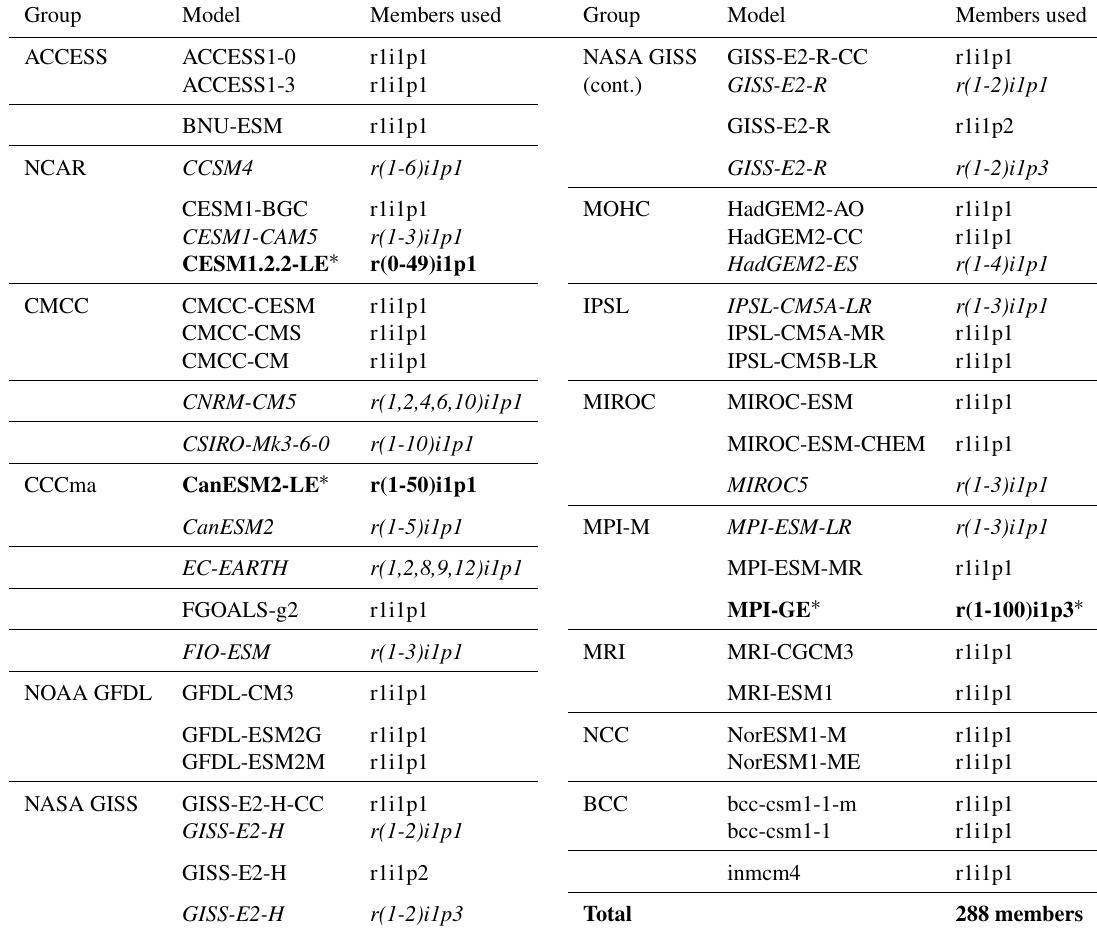
Table 1. Summary of the CMIP5 + SMILE multi-model ensemble used in this study. IC ensembles within CMIP5 are indicated in italics. SMILEs are indicated in bold with a star. Modeling center and/or development stream groupings are separated by horizontal